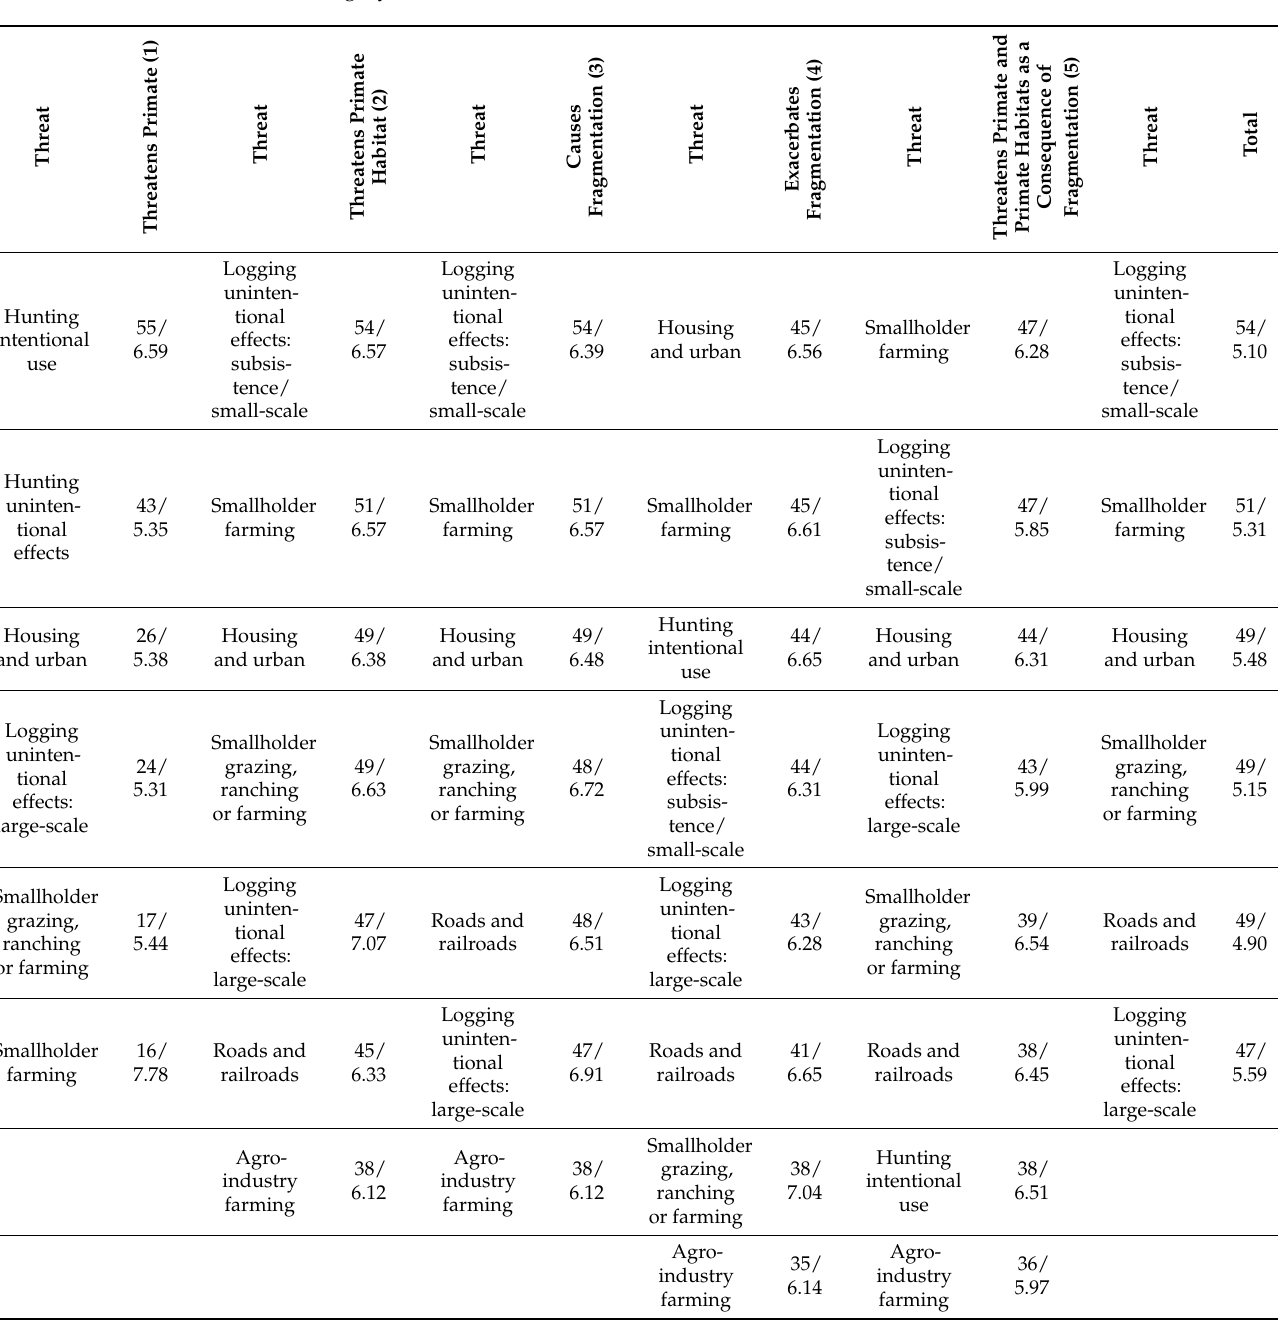
Table 2. Most important causes of fragmentation-related threats to Peruvian primates. Based on the most common and highest scoring threat (excluding climate change). The columns show the threat category and the number of taxa threatened/decimal